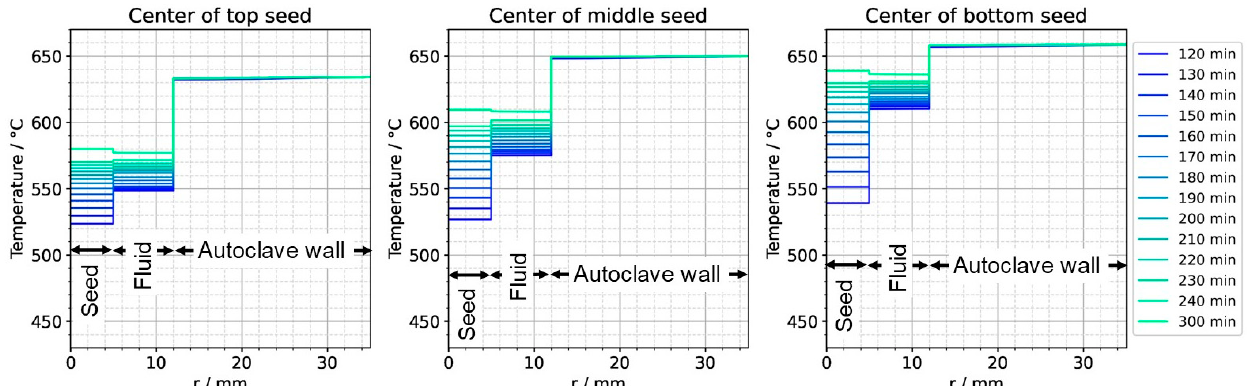
Figure 13. Temperature distribution in horizontal direction through the center of each seed (120 min: reaching of growth stage set temperatures, 300 min quasi-stable conditions of growth stage).